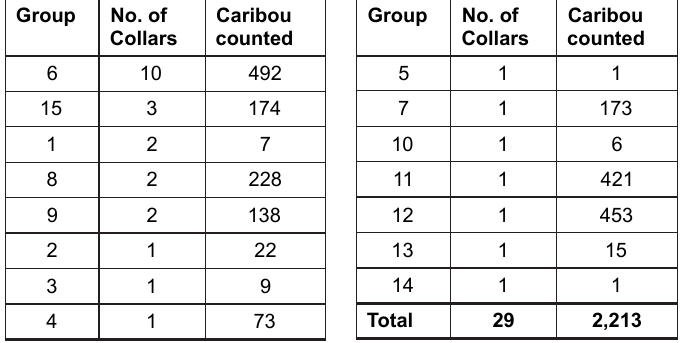
Table 22. Field data for the 2005 Cape Bathurst post calving survey.